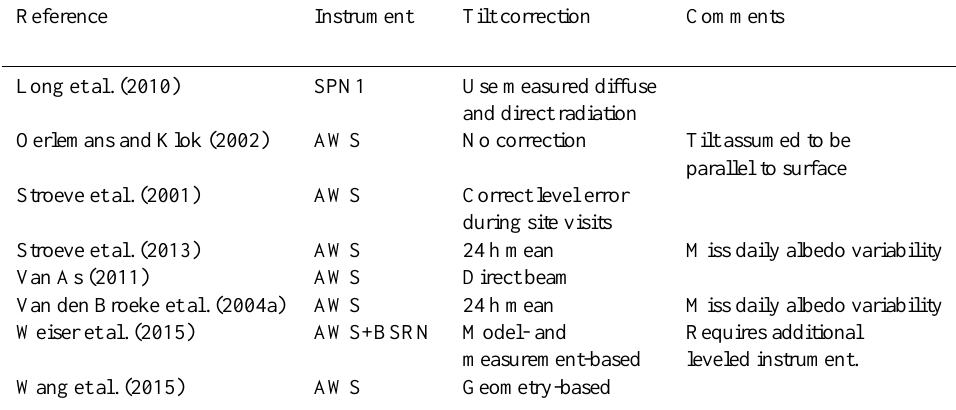
Table 1. Examples of tilt correction